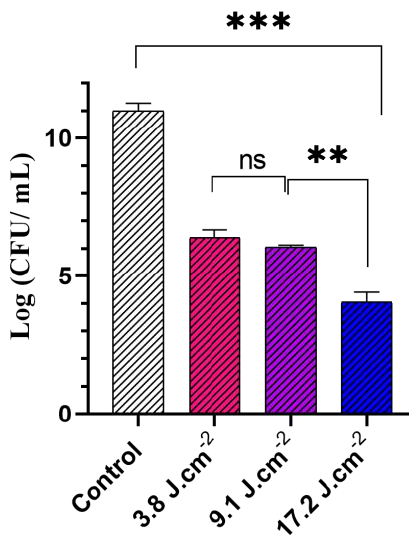
Figure 3. Absorption spectra of GaPP (1.5 µ M) dissolved in 1% DMSO solution (red line) and GaPP-LCNP (1.5 µ M) (green line).